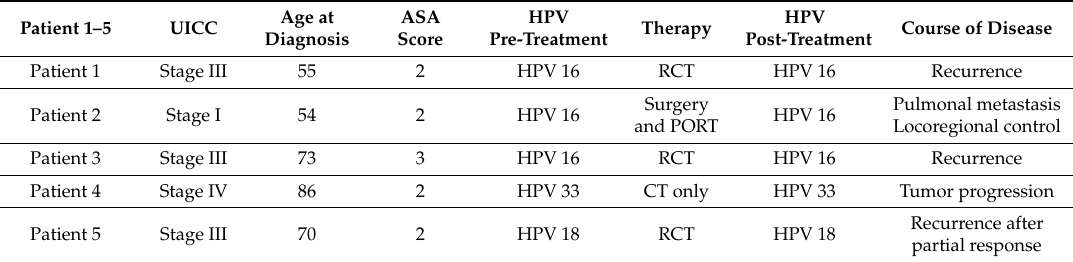
Table 3. Patients with post-treatment HPV-positivity for the same